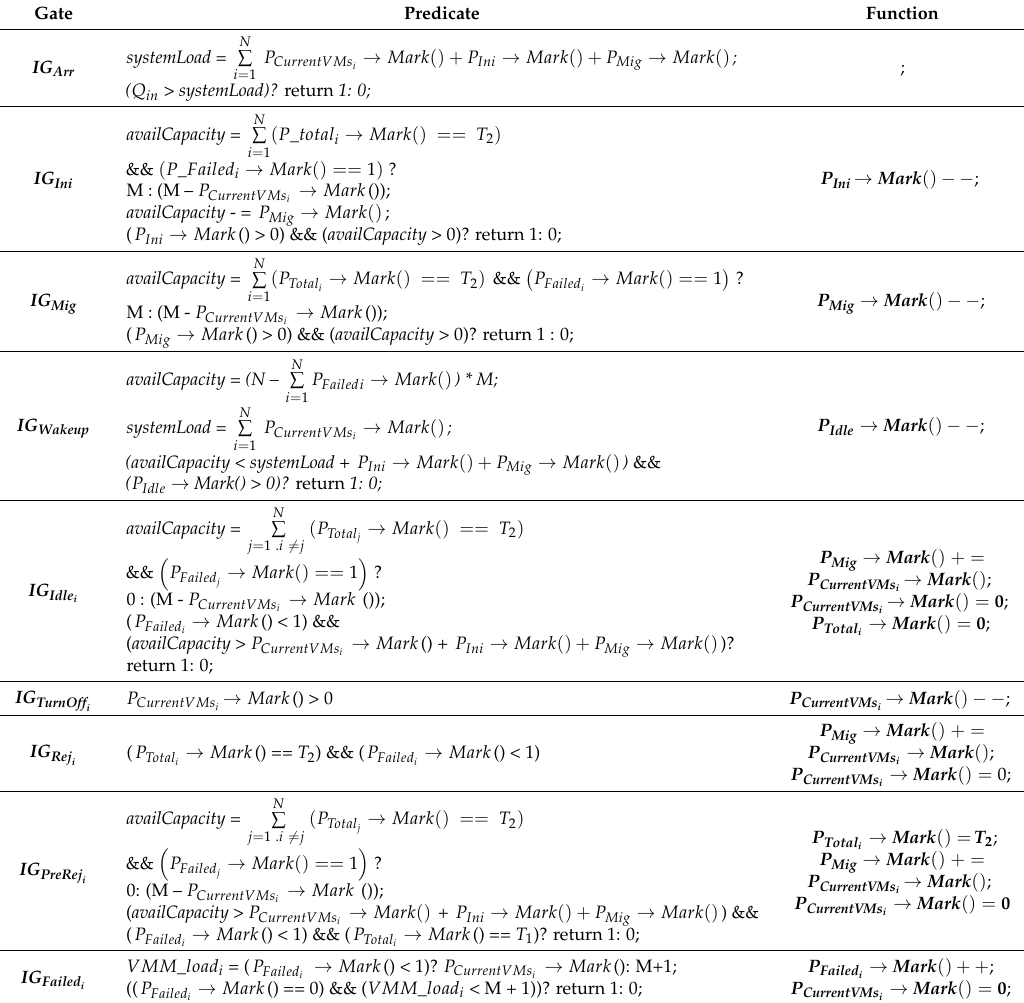
Table 2. Predicates and functions of input gates of the proposed SAN mod.